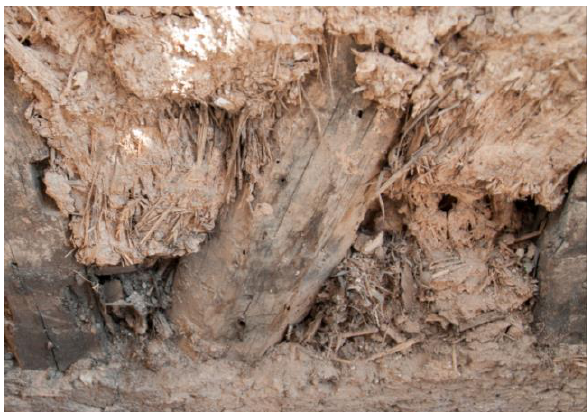
Figure 8. Detail of the half-timbered wall with earth in a house in Ourense. Source: A.F.P.